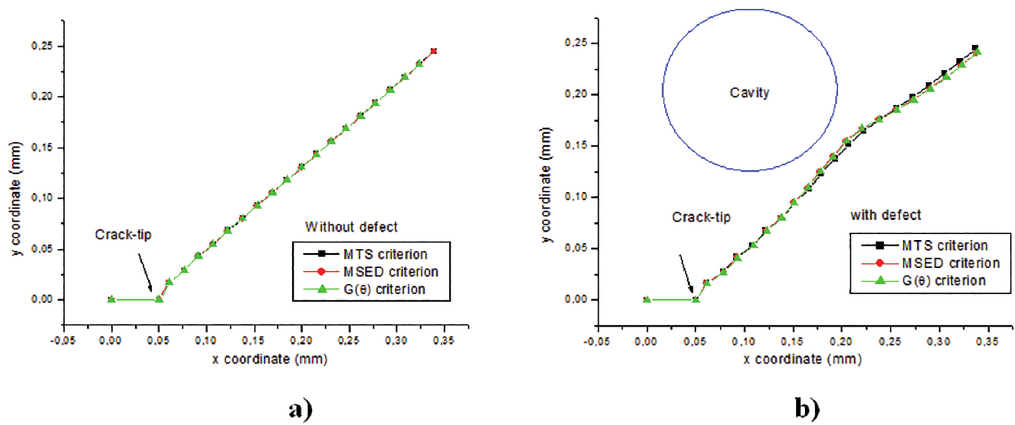
Figure 14: Crack trajectories comparison: a) without defect and b) with